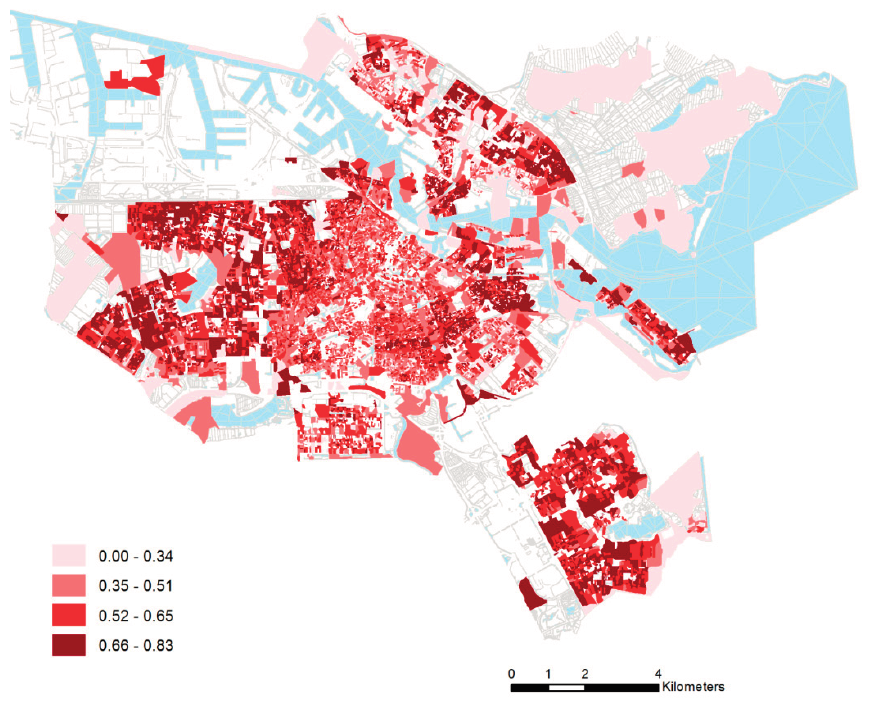
Figure 1. Variations in the degree of ethnic heterogeneity within Amsterdam in 2012 (Herfindahl Index measured for six-digit postcode areas with at least 25